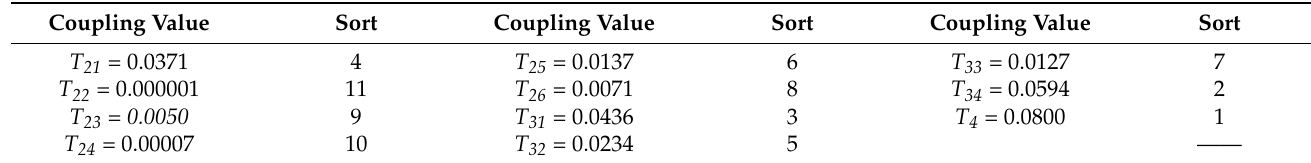
Table 9. Risk Coupling Values of Inland River Accidents.